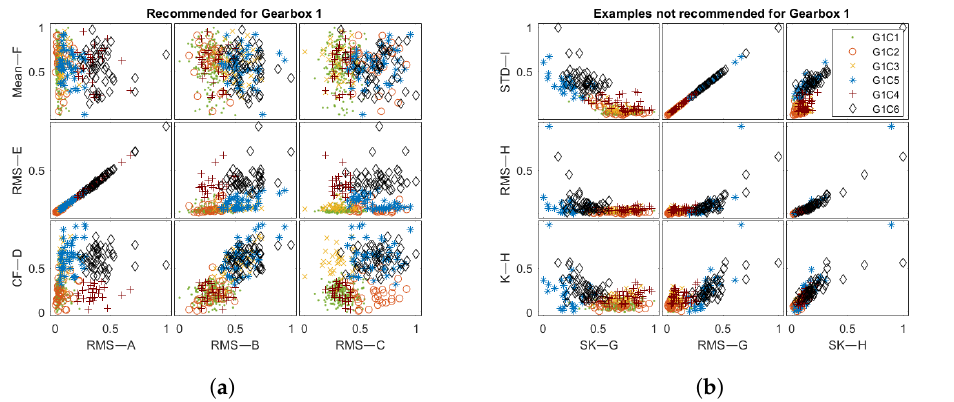
Figure 12. The feature space obtained for the Gearbox 1 test set for: ( a ) recommended and ( b ) not recommended processing chains.